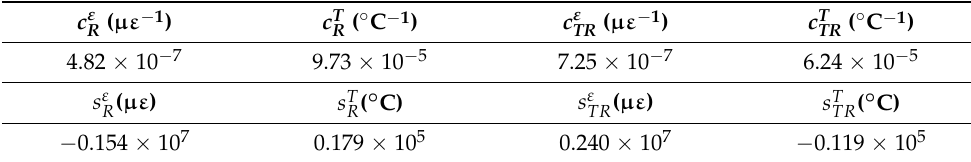
and s ε , T R , TR R ,TR